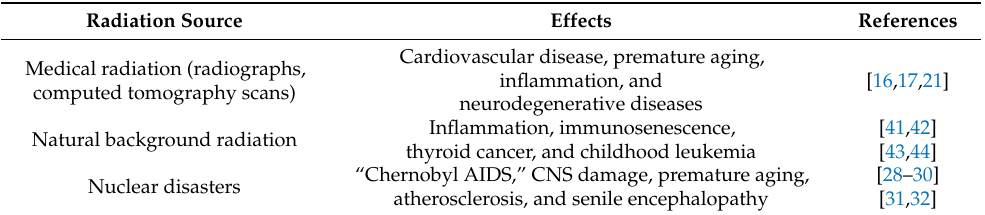
Table 1. Medical conditions caused by different sources of low-dose/dose rate